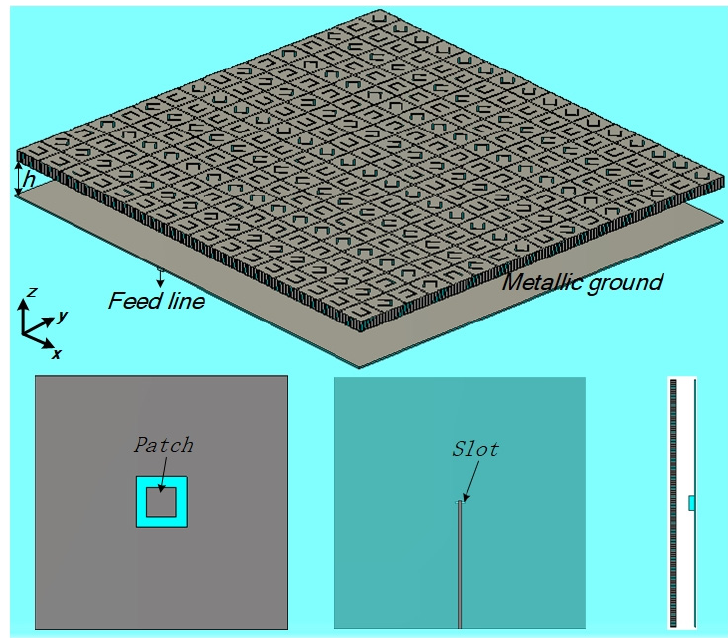
Figure 1. Schematic diagram of the meta-surface FP resonant antennas.